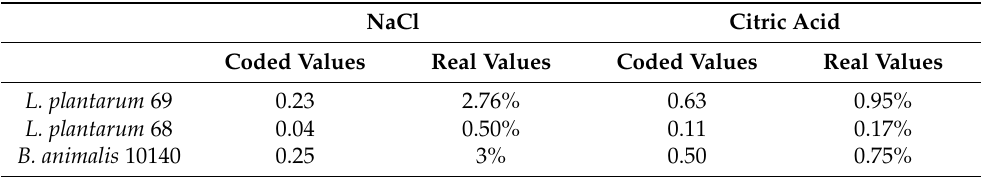
Table 3. Brine optimization. Critical thresholds of NaCl and citric acid for the survival of L.